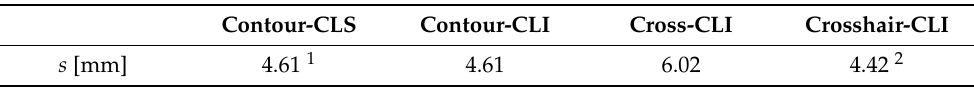
Table 2. Measured distances s representing the degree of warpage for each scanning strategy (substrate: 0.3 mm NiTi SMA